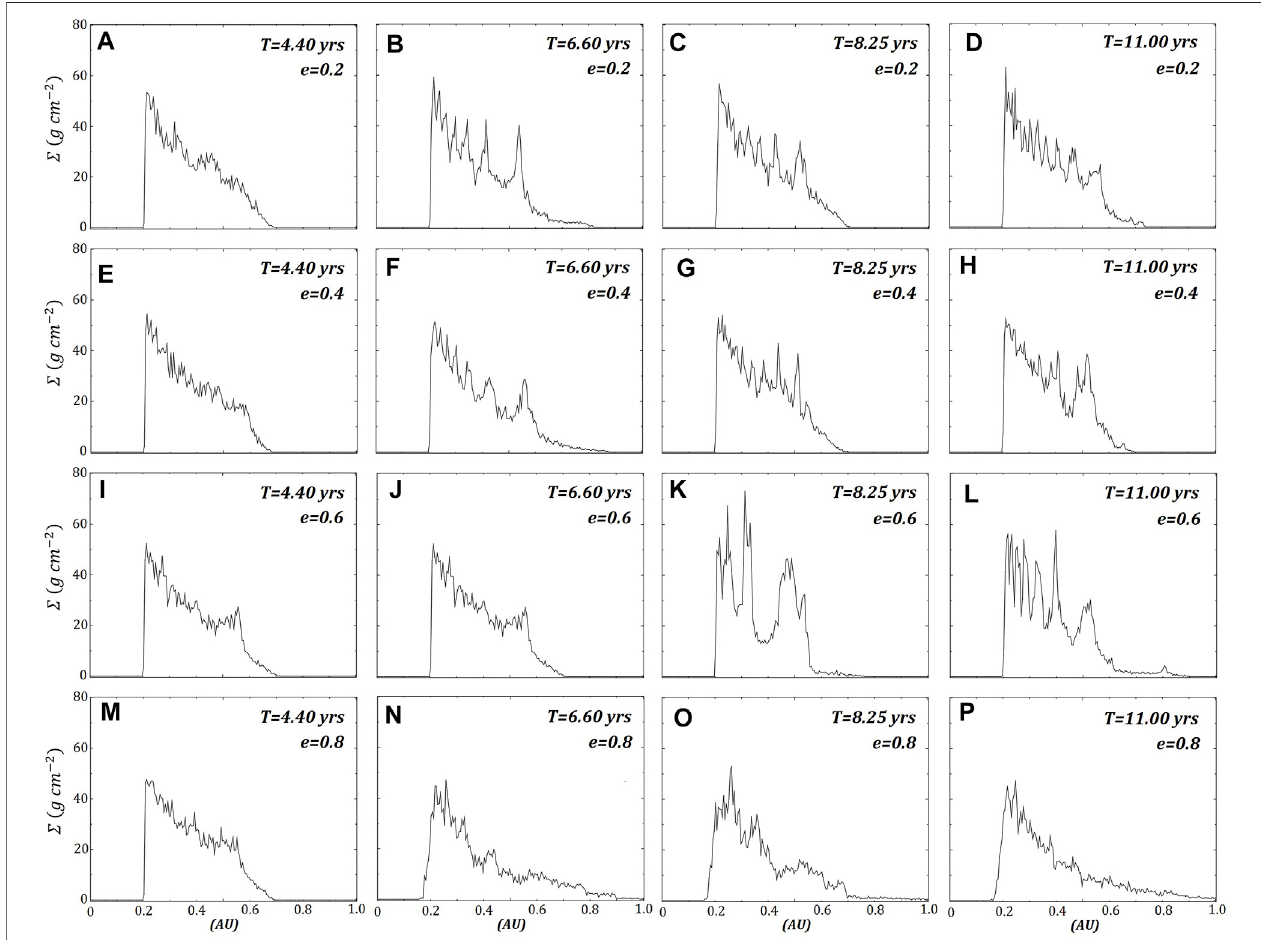
FIGURE 8 | The same four retrograde ring models shown in Figure 3 with their azimuthally averaged surface densities. The rows represent each model, where e (cid:1) 0 . 2 (A – D) , e (cid:1) 0 . 4 (E – H) , e (cid:1) 0 . 6 (I – L) and e (cid:1) 0 . 8 (M – P) , while the column represents a snapshot in time at T (cid:1) 4 . 40 yrs ( A , E , I & M ) , T (cid:1) 6 . 60 yrs ( B , F , J & N ) , T (cid:1) 8 . 25 yrs ( C , G , K & O ) , T (cid:1) 11 . 00 yrs ( D , H , L & P ) , where all models began at apocentre.